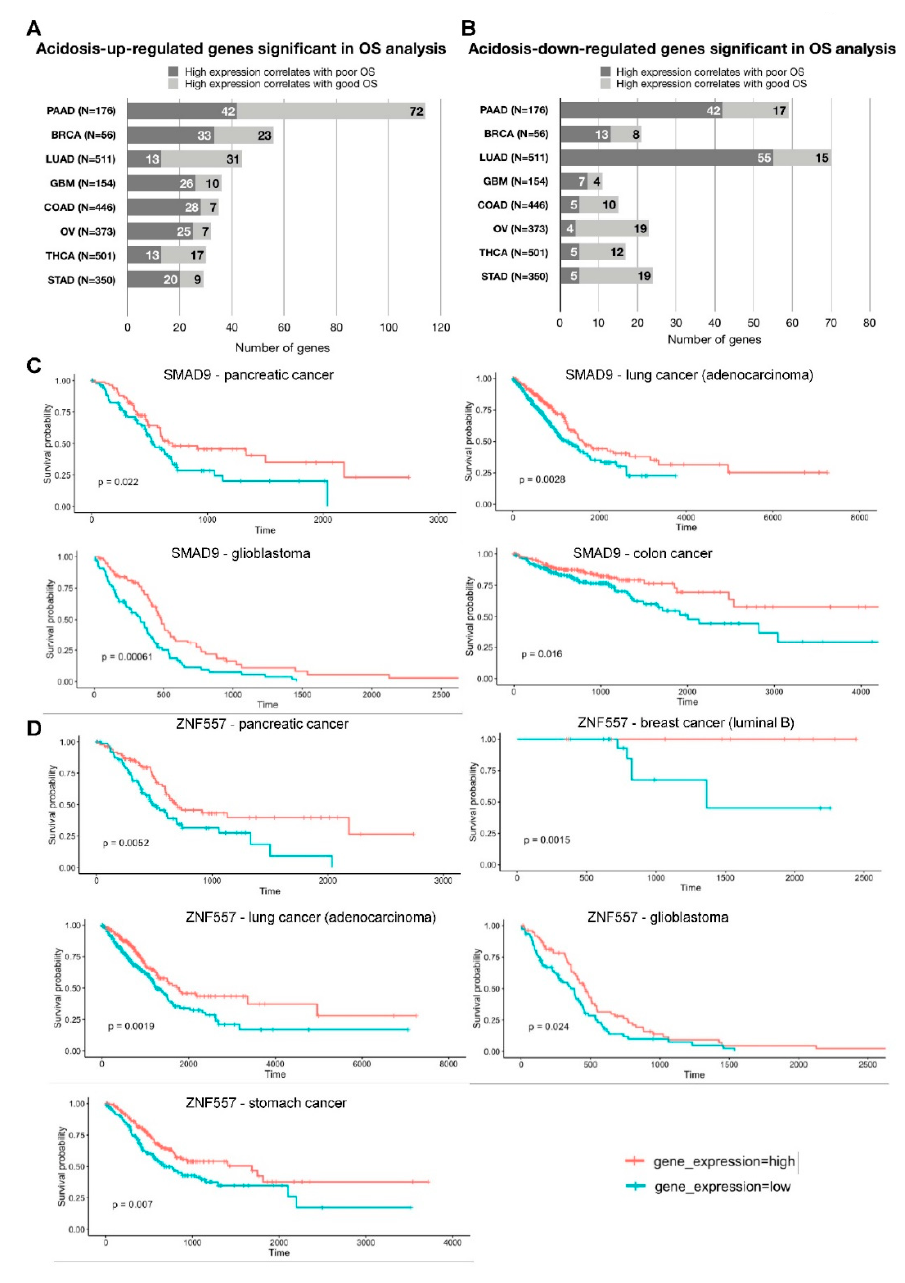
Figure 3. Correlation of genes differentially regulated in chronically acid adaptation cancer cells with patients’ overall survival. ( A ) Summary of patient overall survival (OS) analysis based on acid adaptation-upregulated genes. Bars show the number of genes significantly associated with overall survival ( x -axis), stratified by whether high patient gene expression correlates with poorer or better OS (indicated by bar color). The y -axis shows cancer type, where N is the number of patients analyzed. PAAD—pancreatic cancer, BRCA—breast cancer (luminal B), LUAD—lung cancer (adenocarcinoma), GBM—glioblastoma, COAD—colon cancer, OV—ovarian cancer, THCA—thyroid cancer, STAD— stomach cancer. ( B ) Summary of patient OS analysis based on acid adaptation-downregulated genes. Arranged as in ( A , C ) Survival analysis based on SMAD9 expression levels. Kaplan–Meier overall survival analysis in pancreatic cancer, lung adenocarcinoma, glioblastoma and colon cancer patients, respectively, based on SMAD9 expression levels (GDC TCGA datasets). The y -axis shows survival